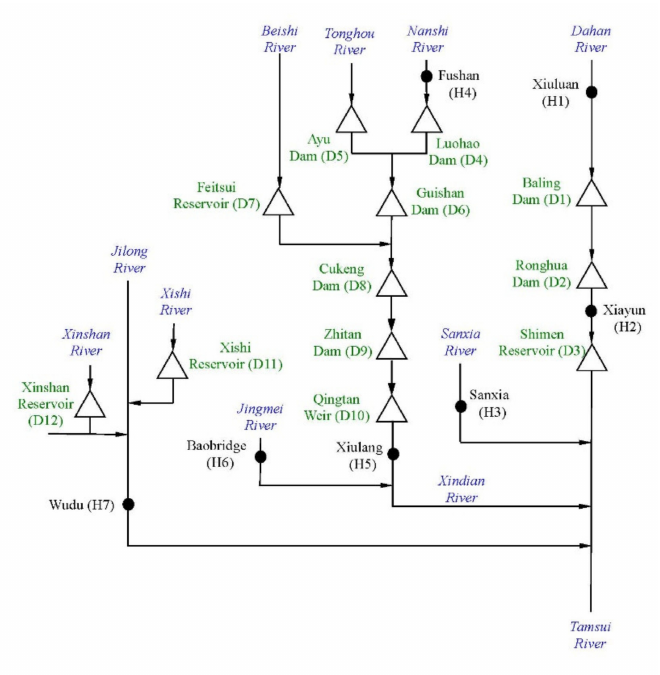
Figure 2. Schematic layout of the Tamsui River system including tributaries, streamflow gauge stations, and dams (not to